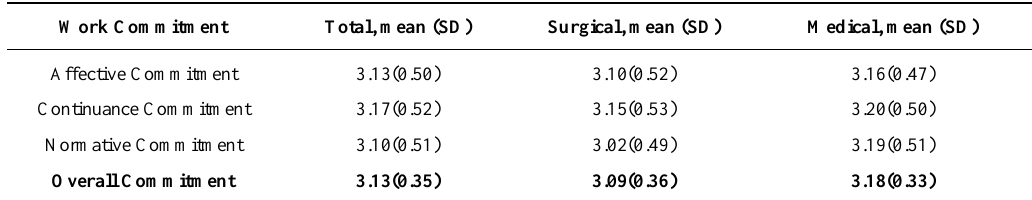
Table 2. Mean Score Value for Work Commitment